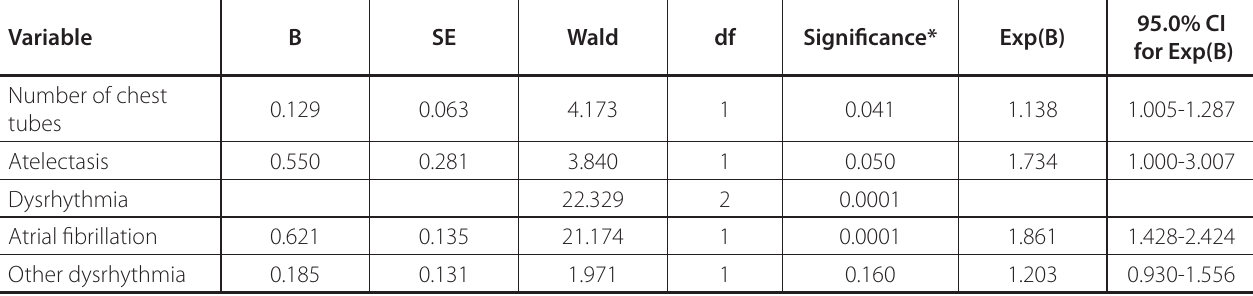
Table 2 . Cox regression hazard model analysis for identifying potential risk factors for length of stay in intensive care unit. Variable